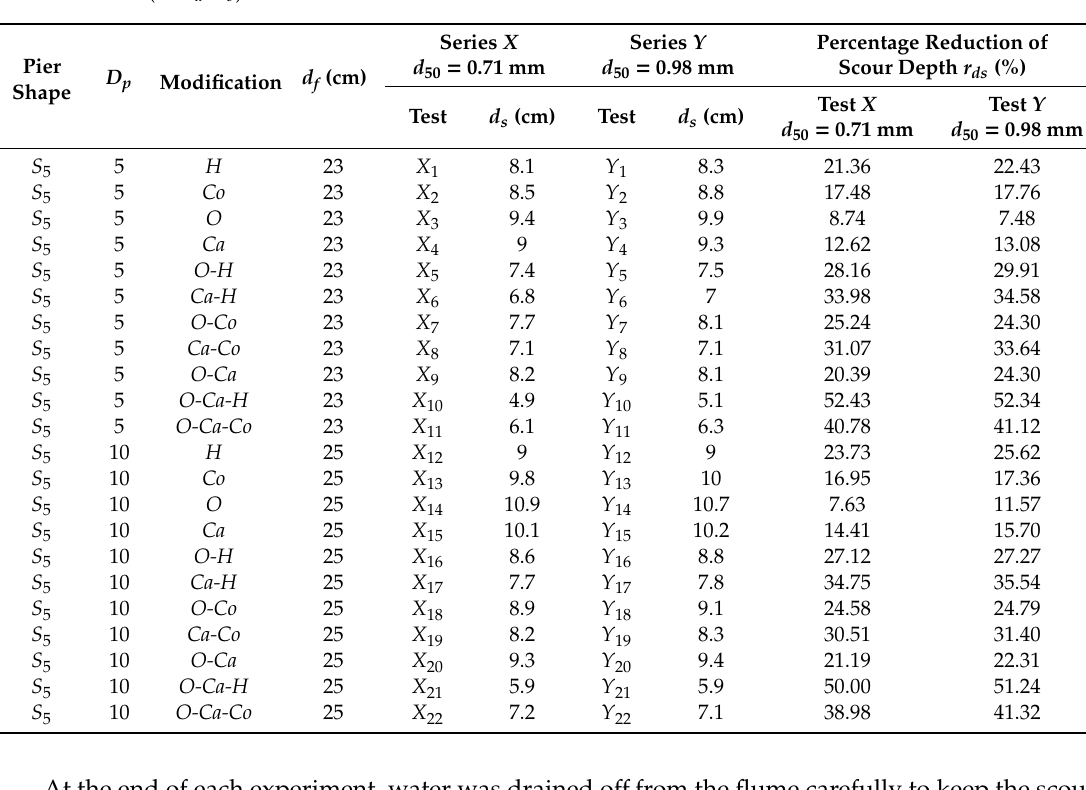
Table 4. Experimental data of modification around octagonal pier in uniform sediments. Hooked collar ( O-H ), cable with hooked collar ( C a -H ), openings with collar ( O-C o ), cable with collar ( C a -C o ), openings with cable ( O-C a ), openings with cable and hooked collar ( O-C a -H ), and openings with cable and collar ( O-C a -C o ).